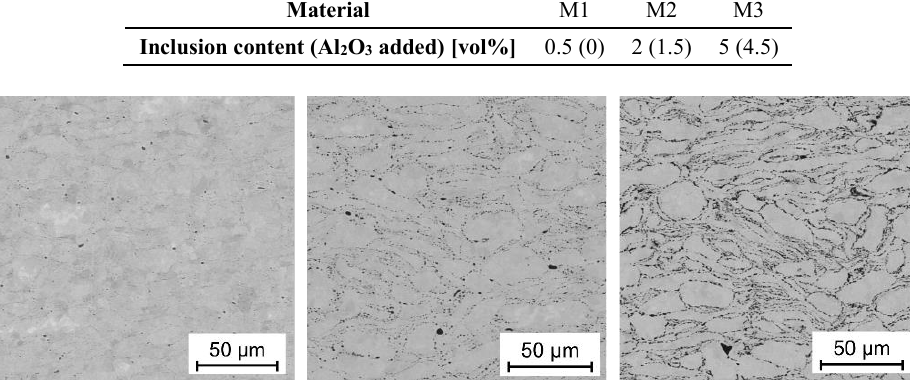
Fig. 1. Microstructure of M1 (left), M2 (center) and M3